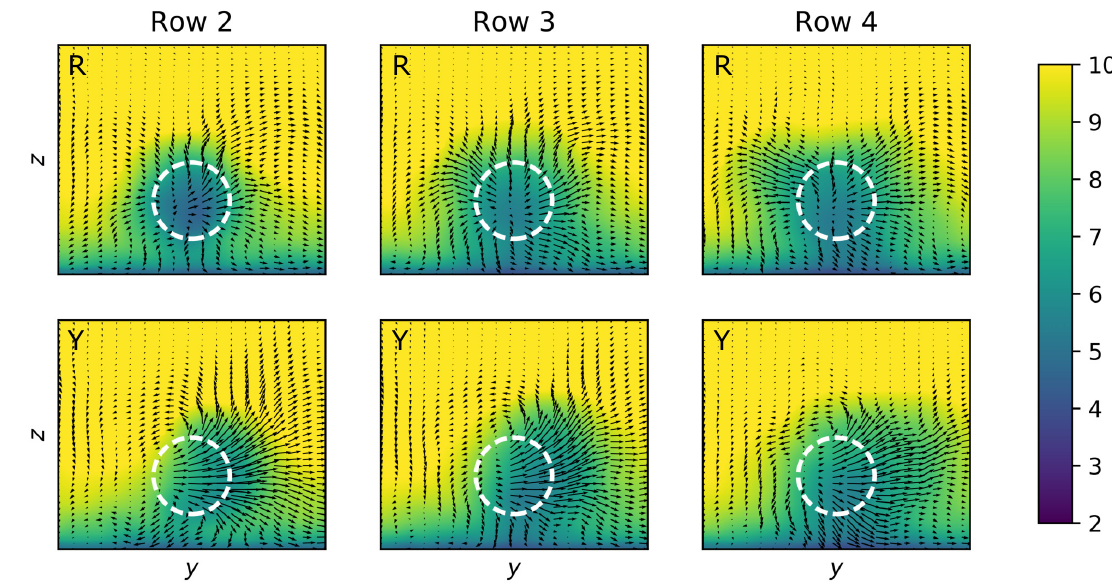
Figure 14. Time-averaged cross-sectional views of streamwise velocity (cid:101) u x at a distance D /2 upstream of the downstream turbines in column C4. Arrows represent the projection of the velocity vector on the cross-sectional plane. Dashed white lines indicate turbine rotor locations. Coloring in m s − 1 .